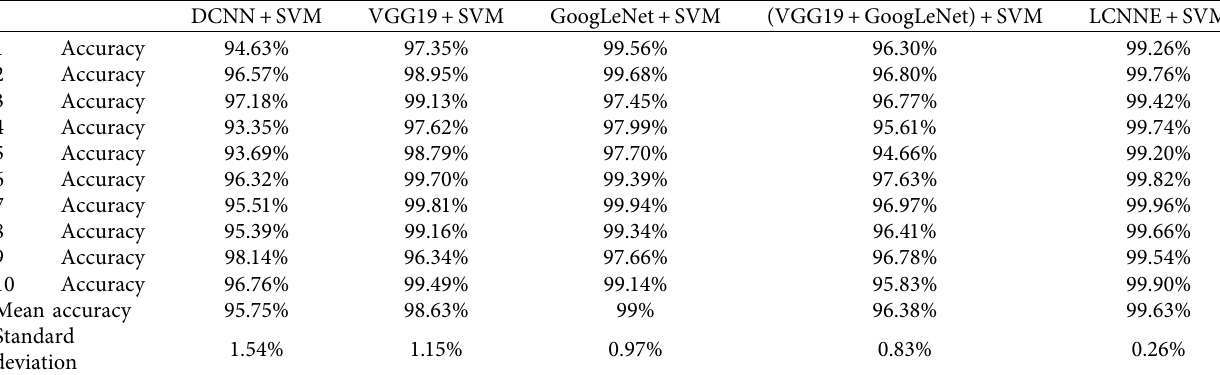
Table 3: Classification accuracy when fine-tuned CNN is used for feature extraction for further input to support vector machine (SVM) classification.